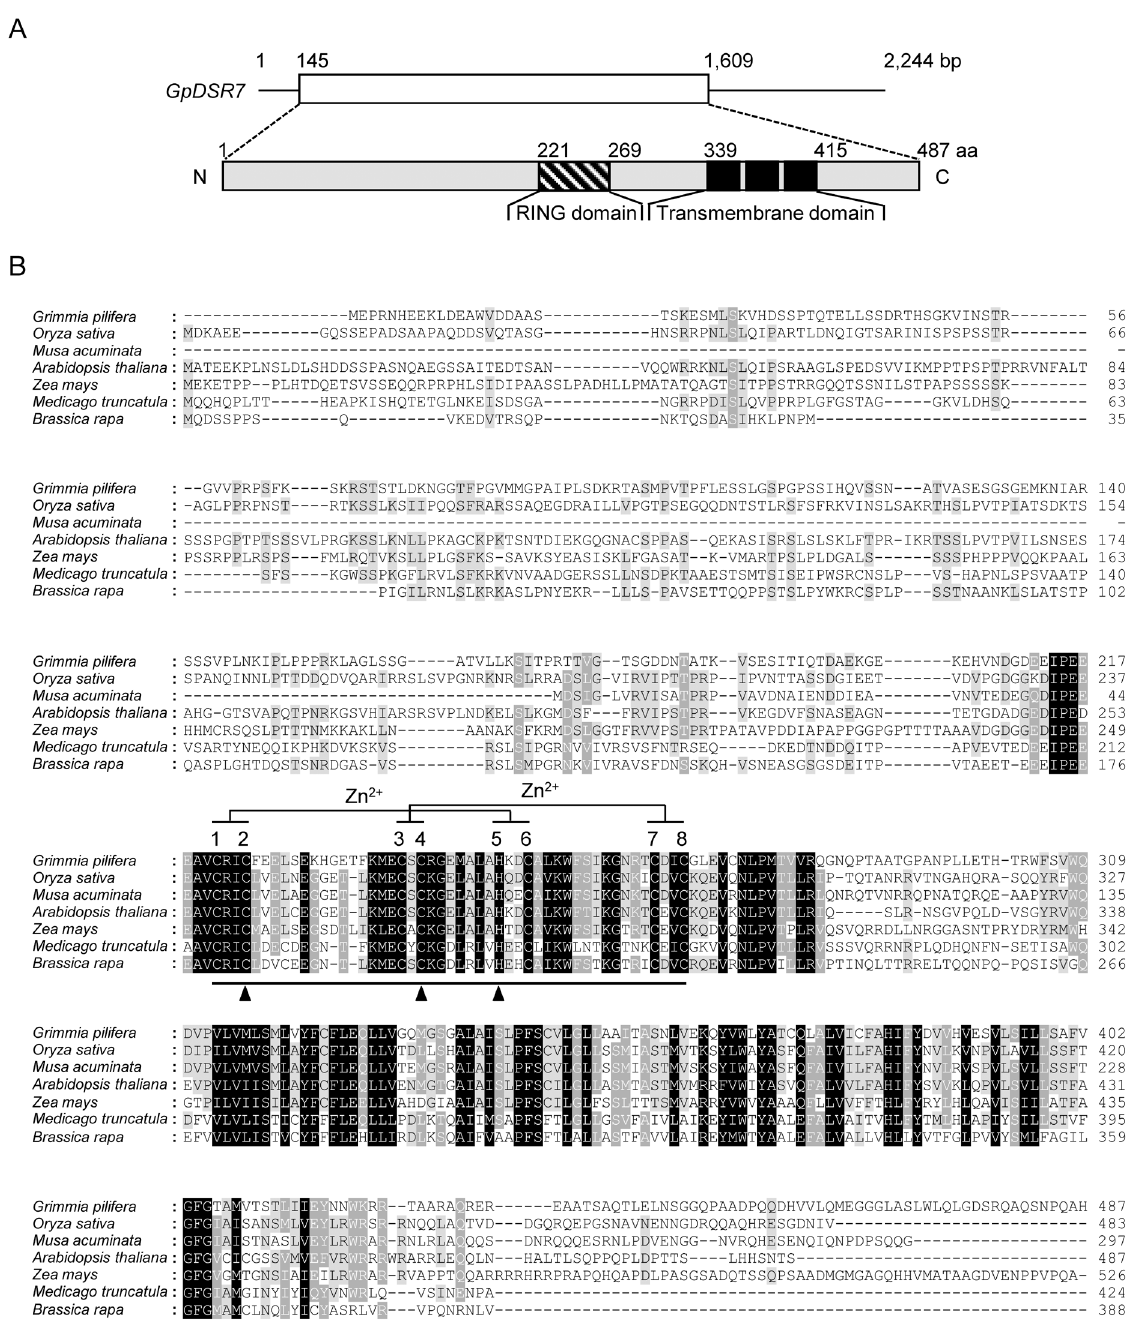
Fig 2. Sequence analysis of GpDSR7. (A) Schematic structure of the GpDSR7 cDNA and predicted GpDSR7 protein. Hatched bar indicates the RING (Really Interesting New Gene) motif, and dark bar indicates the C-terminal putative TM domain. (B) Comparison of the derived amino acid sequence of GpDSR7 with its homologues from other species, including rice (Os06g0677300), Musa acuminata (ABF69983.1), Arabidopsis (At5g60580), maize (NP_001148132.1), Medicago truncatula (XP_003594026.1), and Brassica rapa (ADK63404.1). Solid line denotes the RING motif, and conserved metal ligand positions are indicated by numbered cysteine (C) and histidine (H) residues. Triangles indicate the sites of mutations (C224S, C242S, and